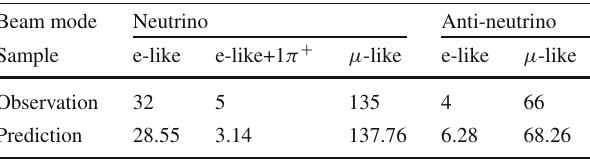
Table 15 The number of observed events from ( 7 . 48 [ ν ] + 7 . 47 [ ν ] ) × 10 20 POT [62]. The MC prediction is based on the oscillation param- eters: sin 2 θ 23 = 0 . 528, sin 2 2 θ 12 = 0 . 846, sin 2 2 θ 13 = 0 . 085,